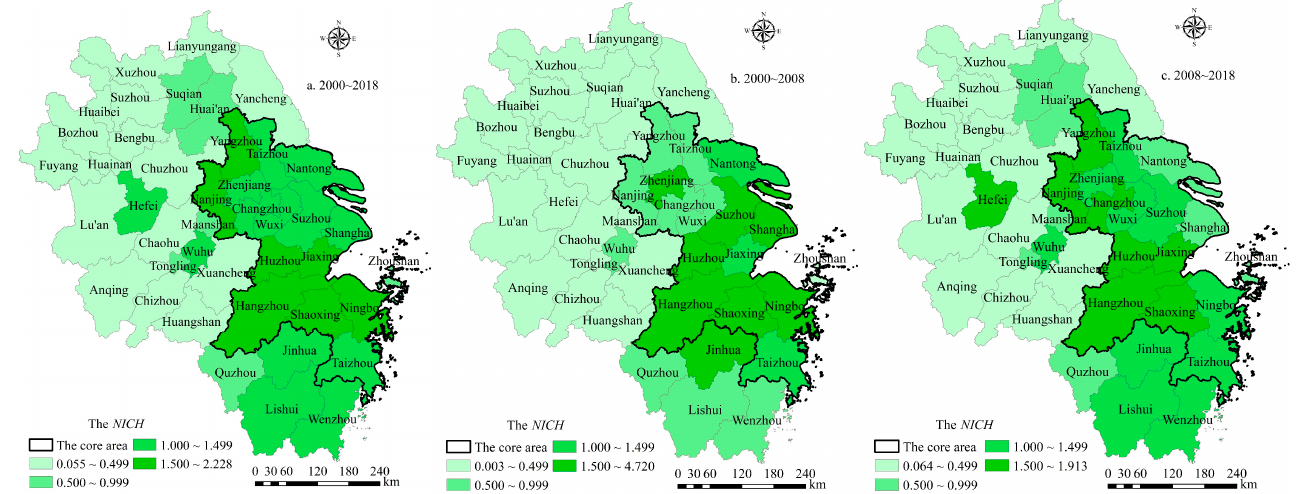
Figure 5. Evolution of innovation growth pattern in the YRD from 2000 to 2018.